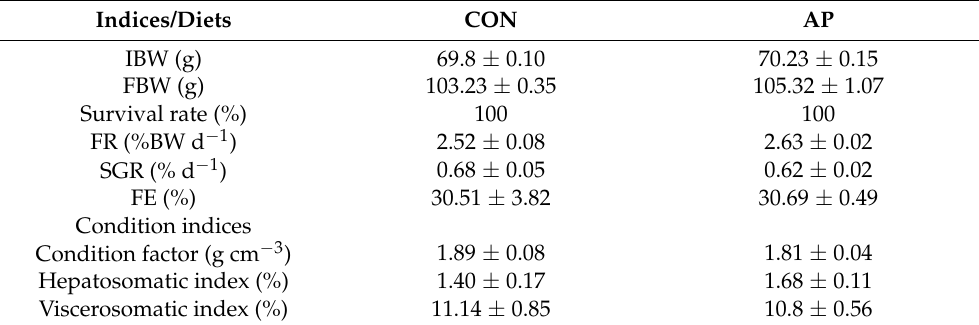
IBW: initial body weight. FBW: final body weight. FR: feeding rate (% body weight day − 1 ) = 100 × (feed intake in dry matter)/[days × (initial body weight + final body weight)/2]. SGR: specific growth